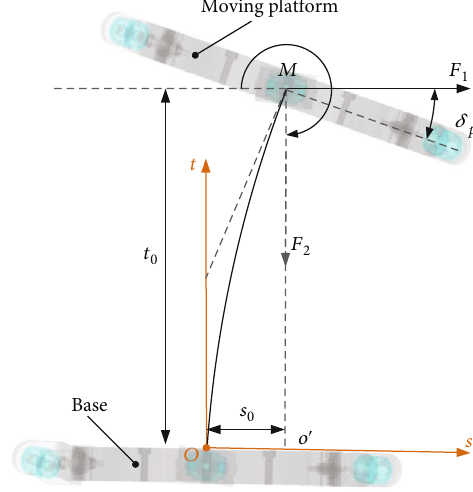
Figure 10: Force and torque balance